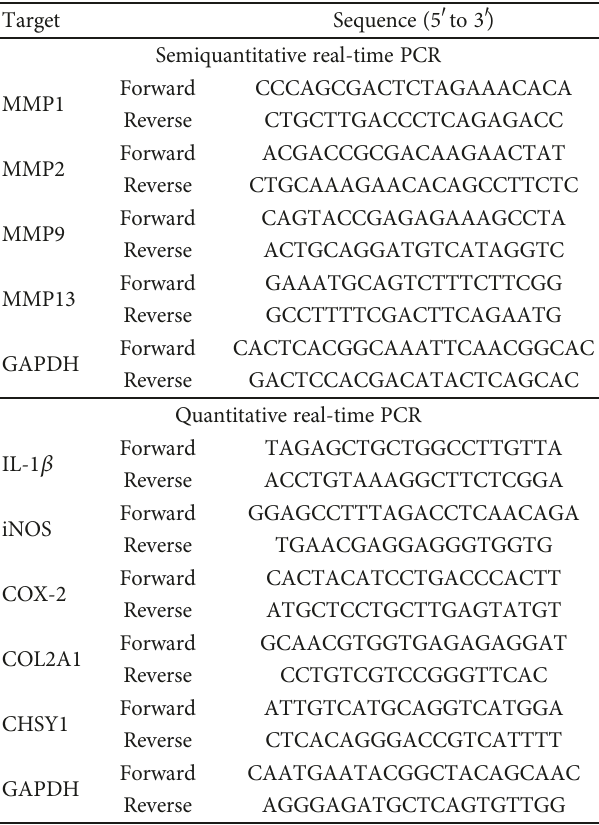
Table 1: Nucleic acid sequences of the primers used for PCR. Target Sequence (5 ′ to 3 ′